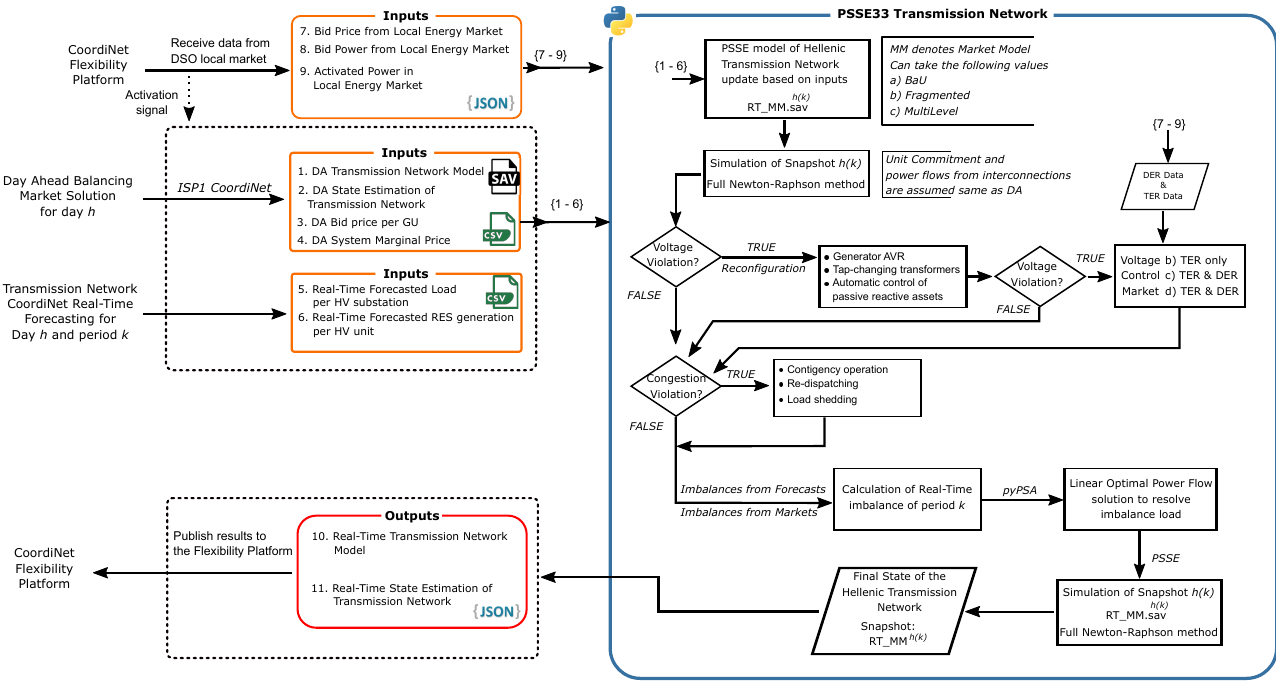
Figure 2. Architecture of the Real-Time Balancing Market Validation